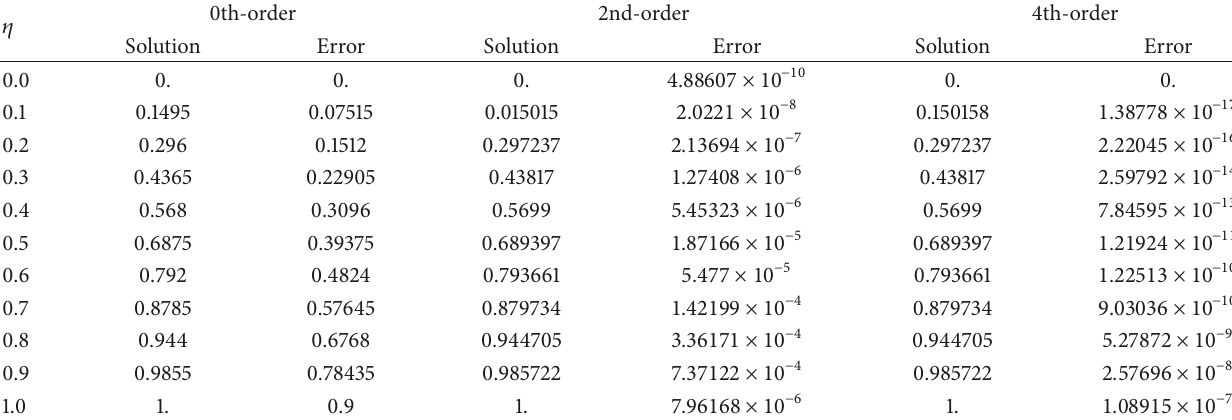
Table 5: Various order HPLM solutions along with absolute residual errors.